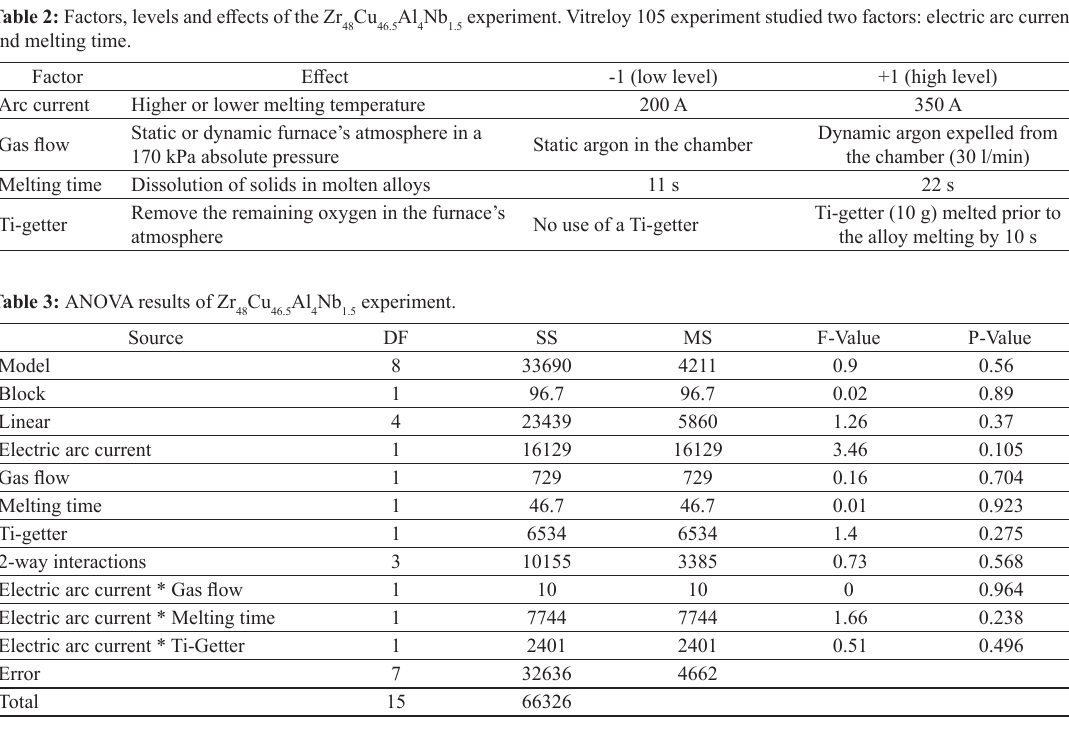
Cu Al Nb experiment. Vitreloy 105 experiment studied two factors: electric arc current 48 46.5 4 1.5